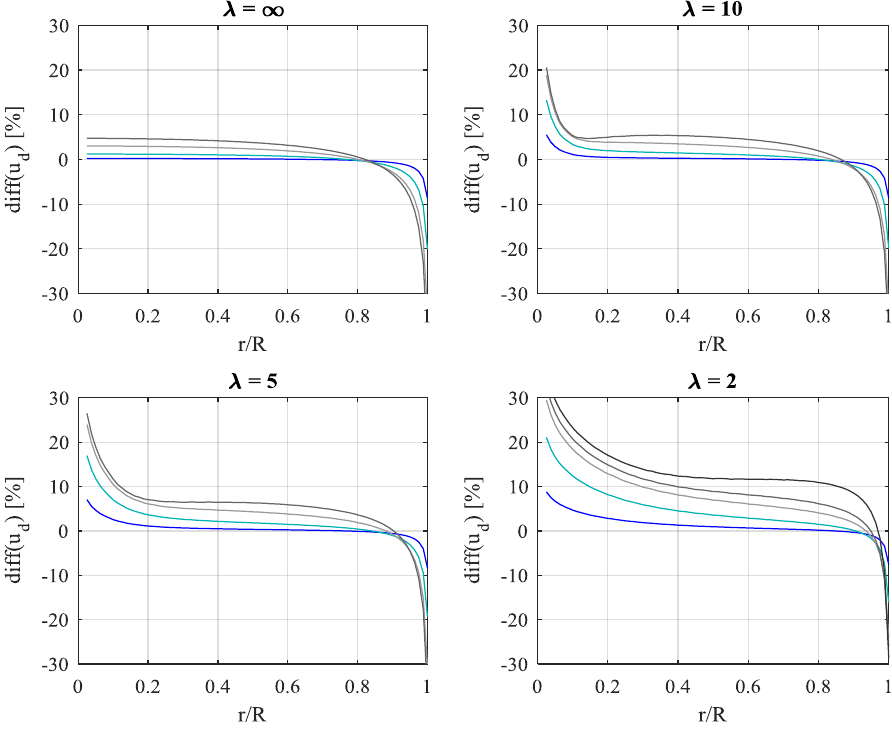
Figure 6. BEM results compared to AD.